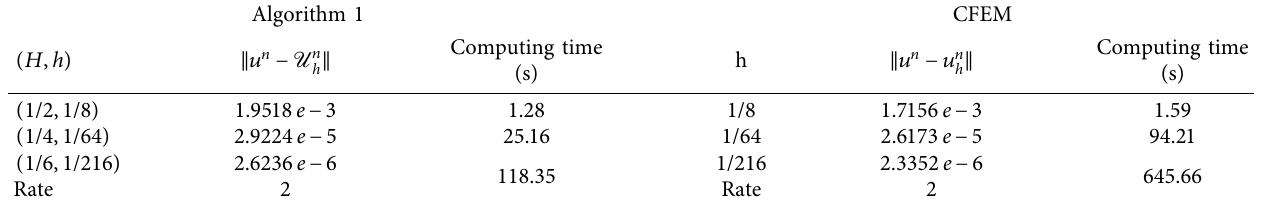
Table 1: Numerical results of Algorithm 1 and CFEM.